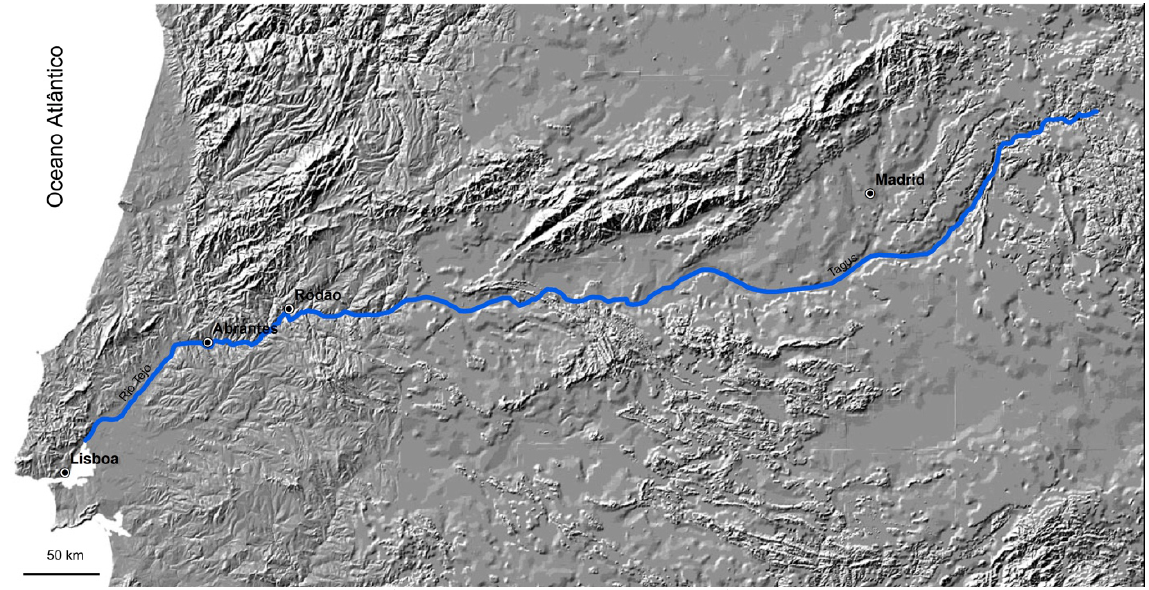
Figura 1. Modelo digital de terreno (dados altimétricos do SRTM v4) da região atravessada pelo rio Tejo, na Península Ibérica, até à foz no Oceano Atlântico (1.076 km). De leste para oeste, distinguem-se o Alto e o Médio Tejo, no relevo quase plano na Bacia Cenozóica de Madrid, e depois o sector português do Tejo, na Bacia Cenozóica do Baixo Tejo, particularmente desenvolvida a jusante de Abrantes. Entre as duas bacias cenozoicas o Tejo corre num vale encaixado ca. 200 m no soco metamórfico e granitoide. Figure 1. Digital elevation model (altimetry from SRTM v4) of the region crossed by the Tagus River, in the Iberian Peninsula, until the river mouth in the Atlantic Ocean (1,076 km). From east to west, the river crosses the low relief landscape of the Madrid Cenozoic basin (the High and Middle sectors of the Tagus drainage basin), the narrow transition area in which the river is ca. 200 m incised in the metamorphic and granitic basement, and the downstream sector along the Lower Tagus Cenozoic basin, well developed downstream of